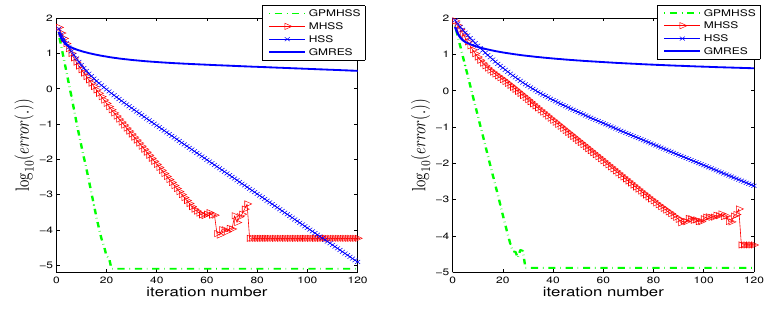
Figure 3. The log 10 of the residual error versus iteration number for Example 1, with n = 20 × 20 (left) and n = 40 × 40 (right).